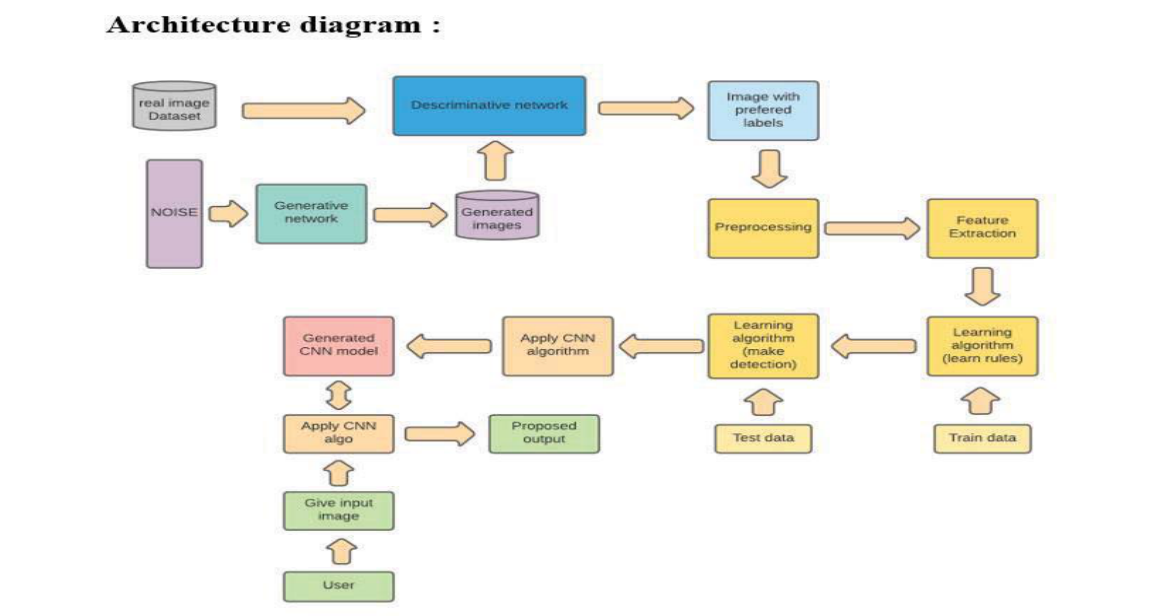
Fig. 3. The architecture of the system A conditional variable from the previous step is sent to the generator model along with some random noise which is normally distributed with a mean of 0 and variance of 1. This is upsampled in the generator to create stage 1 images or low-resolution images of the format 64x64. These images along with the real images are compared and downsampled and then sent to the discriminator. In the discriminator, the output of the downsampling block is concatenated with the spatially compressed embeddings and sent to the classifier to classify whether the image is a real or fake image. Low-resolution images created in stage one are sent to the stage two generator along with the text embedding. The second layer has its conditioning augmentation